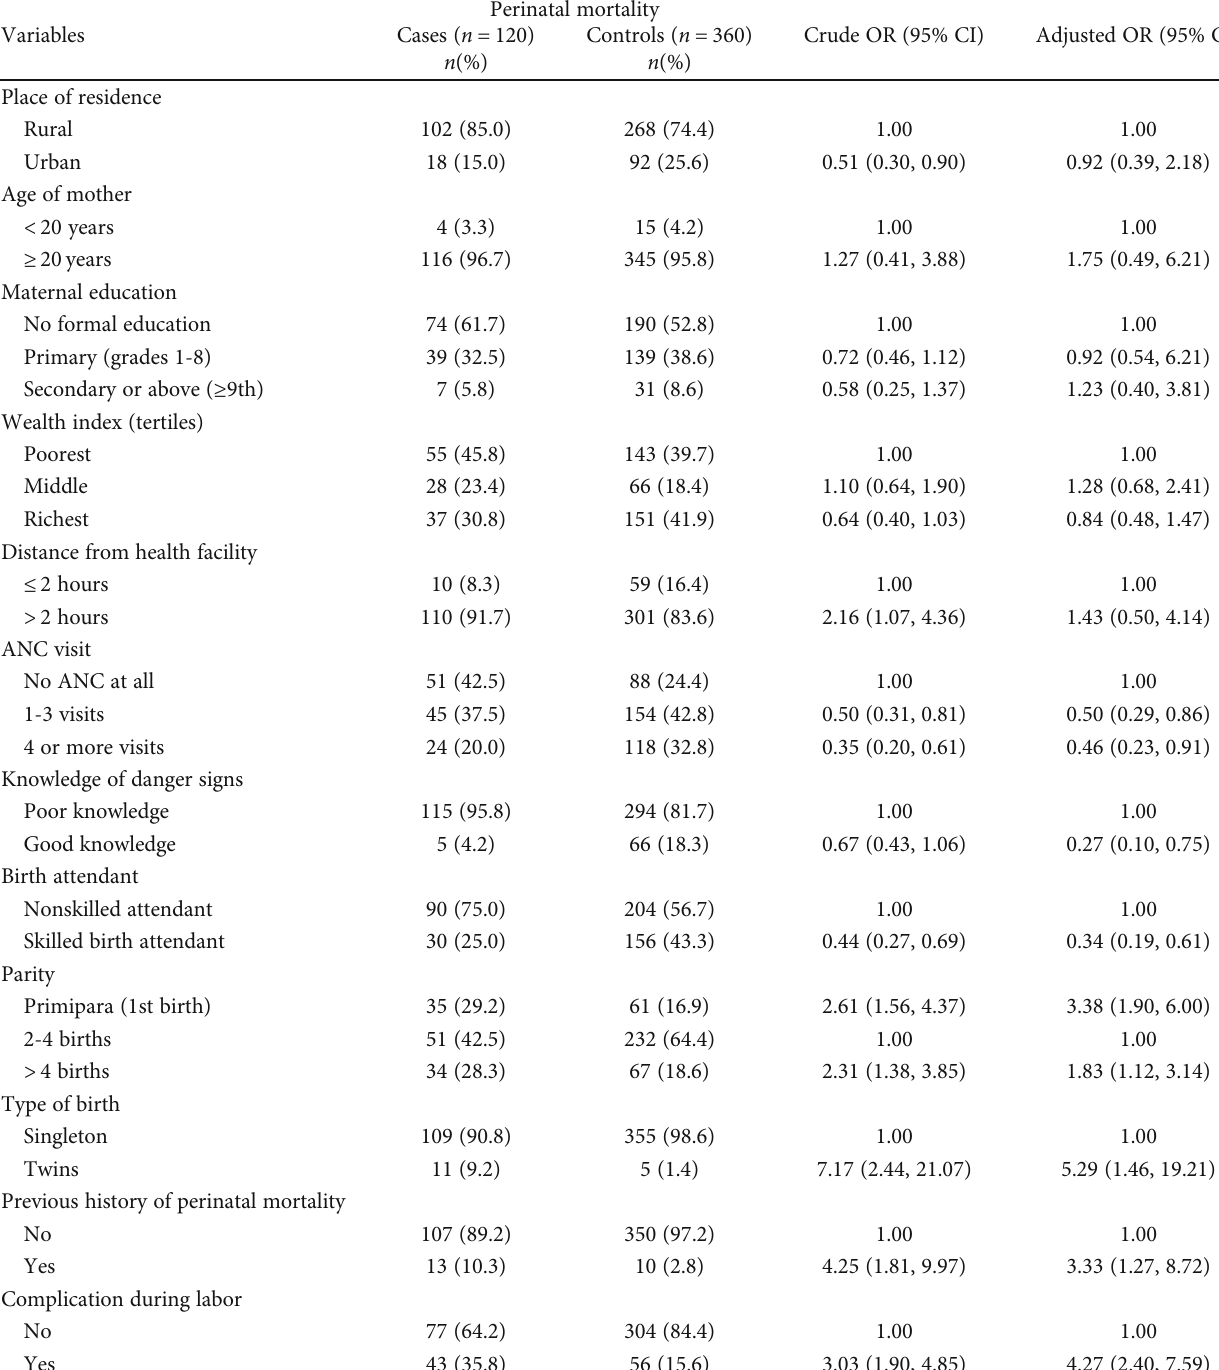
Table 2: Determinants of perinatal mortality in Jimma Zone, Southwest